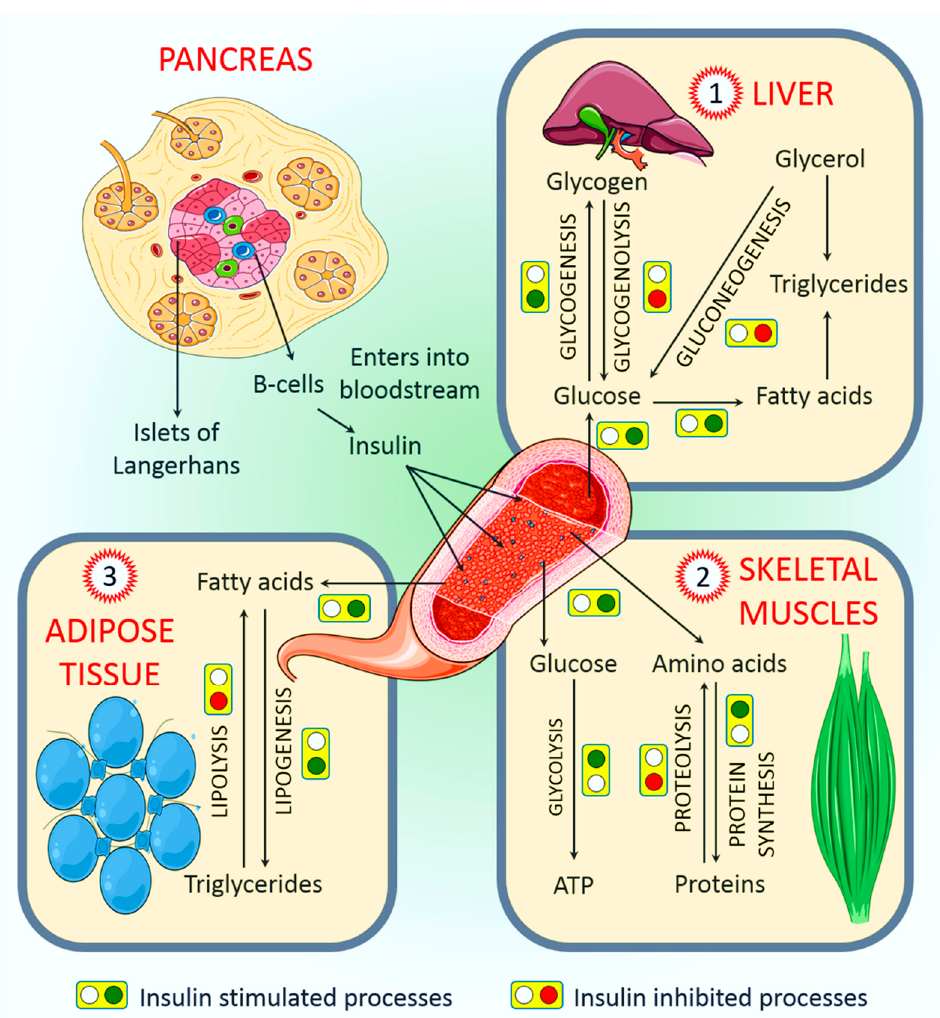
Figure 2. Major physiological roles of insulin in the liver, adipose tissue, and skeletal muscles. After production and release from pancreatic β cells, insulin enters the bloodstream to ultimately reach all other organs. In the liver, insulin helps promote the transport of glucose from the blood into hepatocytes, where it is further converted to glycogen, fatty acids, and triglycerides. In the skeletal muscles, insulin facilitates the uptake of glucose and amino acids from the bloodstream. The amino acids are subsequently used for functional protein synthesis, while glucose is mostly utilized in glycolysis to produce energy in the form of ATP. Glucose may also be converted to the glycogen that is mostly stored as energy for times of deficit. Insulin stimulates adipose tissue uptake of fatty acids, which are later converted into triglycerides and used as long ‐ term energy stores. It is important to note that each of the steps/processes regulated by insulin in the figure are reversible. Whenever insulin stimulates the processes, they are generally irreversible.